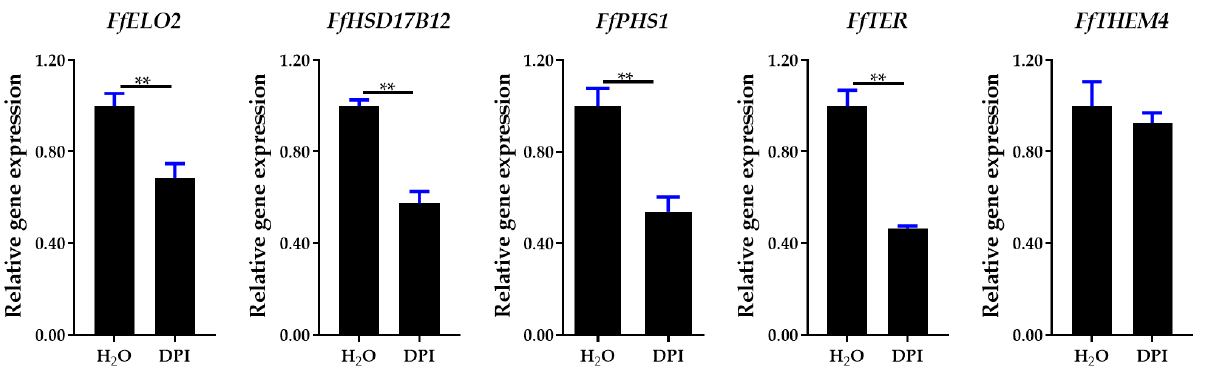
Figure 13. Expression of long-chain fatty acid synthesis of fatty acid elongation pathway (PATH: map00062, Module: M00415) genes in DPI and water treatment samples. Significance levels were calculated by t -test ( n = 4), ** p < 0.01.